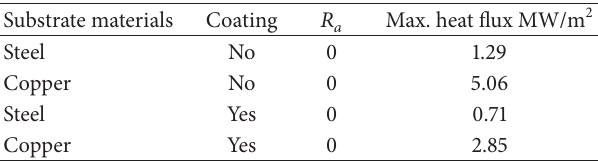
Table 4: Maximum values of heat flux from 3 mm strips of magnesium cast on macrotextured copper substrate.